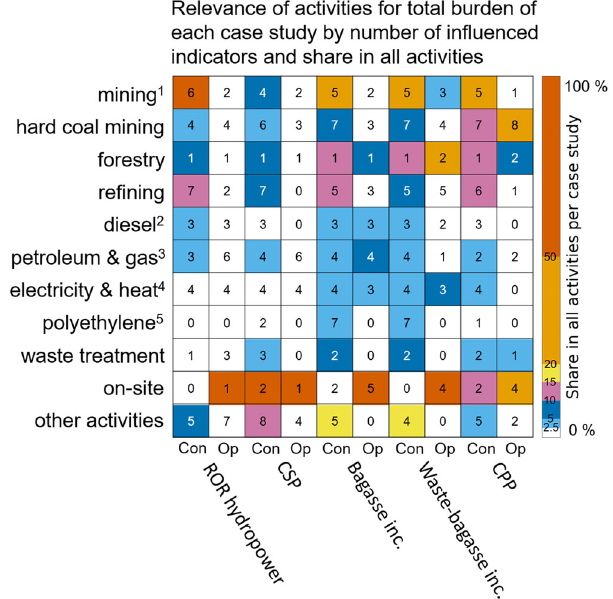
Fig. 6 Relevance of activity categories for total environmental burden of each case study by number of in fl uenced indicators and share. Numbers represent the number of environmental pressures and impacts to which a category contributes. For example, in the construction phase of the ROR hydropower mining activities appear in the assessment of six LCIA indicators. Colours represent the share of a category in the total environmental burden of a case study. 1 Mining without hard coal mining, 2 burning of diesel, 3 production of petroleum and (natural) gas, 4 production of electricity and heat, 5 production of polyethylene. ROR run-of-river, CSP concentrated solar power plant, Bagasse inc. Bagasse incineration, CPP coal- fi red power plant, Op Operation, Con Construction.